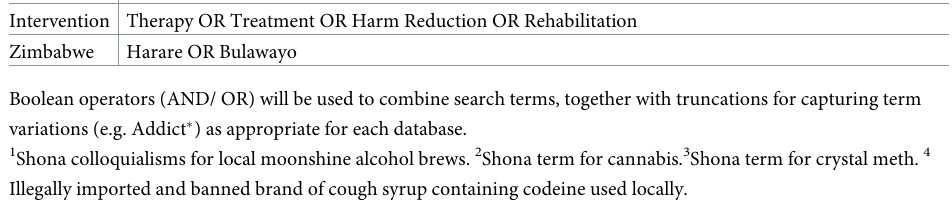
Table 1. Search terms. Keyword